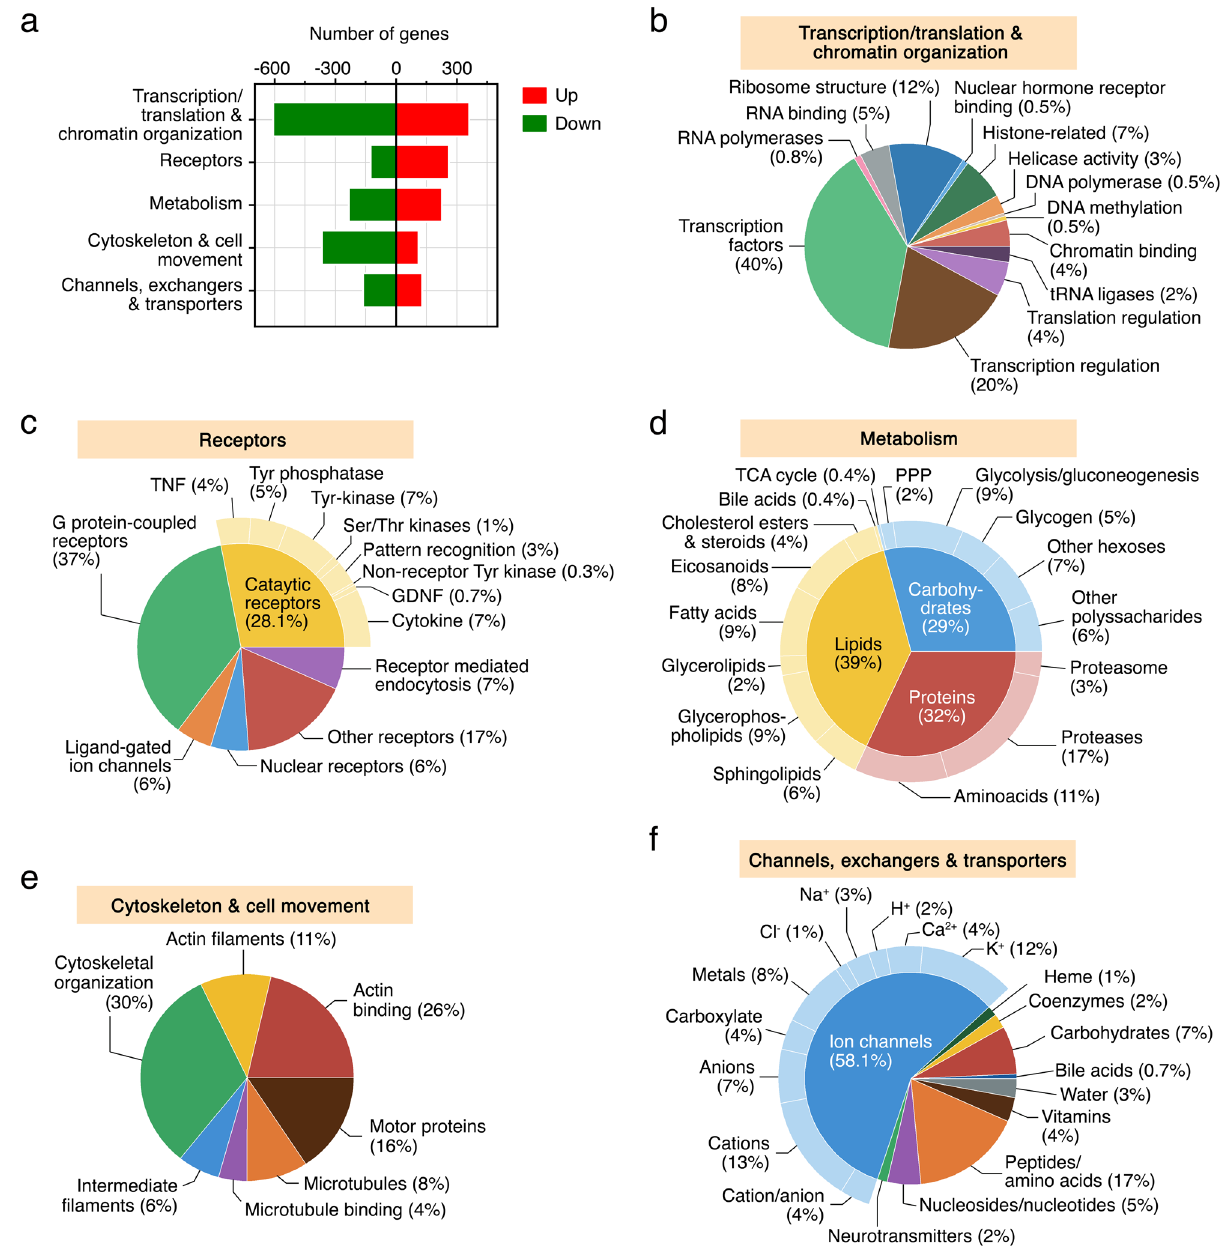
Figure 3. Functional classification of DEGs during sperm differentiation and maturation. ( a ) Transcriptional regulation of a subpopulation of DEGs classified into five functional categories: transcription and translation and chromatin organization, receptors, metabolism, cytoskeleton and cell movement, and channels, exchangers and transporters. ( b – f ) Pie charts showing the GO term distribution of upregulated DEGs in SPZ EJ included in each of the five functional groups. The numbers are the percentage of genes in each category. Plots were generated using the GraphPad Prism v8.4.3 (686) software (https:// www. graph pad. Most of the receptor-encoding upregulated genes (266 genes) were G protein-coupled receptors (37%), tyros- ine phosphatase and kinase receptors (11%), cytokine receptors (7%), as well as other receptors mainly including glycoprotein, Fc, and scavenger receptors (17%) (Fig. 3c). The highest expressed genes in each of these groups were lysophosphatidic acid receptor 6 ( lpar6 ), potentially involved in protection of oxidative stress, receptor-type tyrosine- phosphatase C ( ptprc ), interleukin-1 receptor type 1 ( il1r1 ), and zona pellucida sperm-binding protein 3 ( zp3 ), likely implicated in the sperm-egg interaction (Suppl. Table S2). For the upregulated genes encoding metabolic components (230 genes), those related to the metabolism of lipids, proteins and carbohydrates were almost equally represented (39, 32 and 29%, respectively) (Fig. 3d). The most enriched genes in SPZ EJ belonging to these groups were those related to glycerophospholipid hydrolysis and fatty acid biosynthesis (18%), such as lysophosphatidylserine lipase ABHD12 ( abhd12 ) and elongation of very